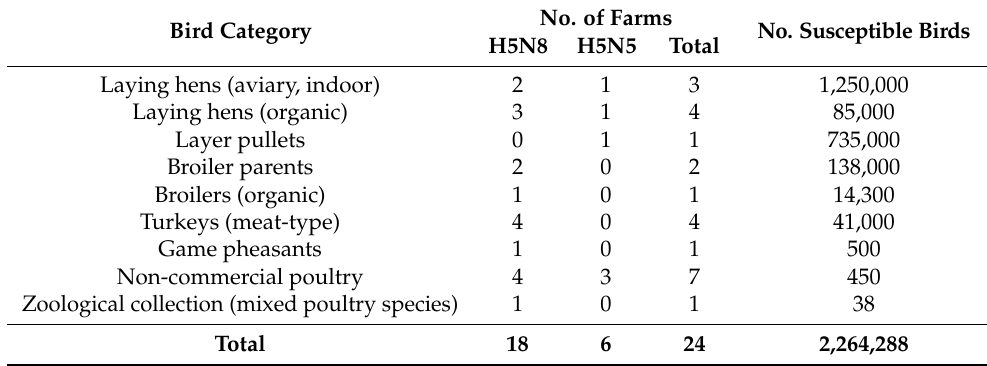
Figure 1. Weekly reports of diseased/dead wild birds to the National Veterinary Institute, number of wild birds sampled and H5 positive or negative within the avian influenza surveillance program and number of outbreaks in poultry and other captive birds during the influenza season 2020–2021 in Sweden. Note different scales on left and right X-axes. Table 2. Summary of HPAI outbreaks in poultry and captive birds during the 2020–2021 season in